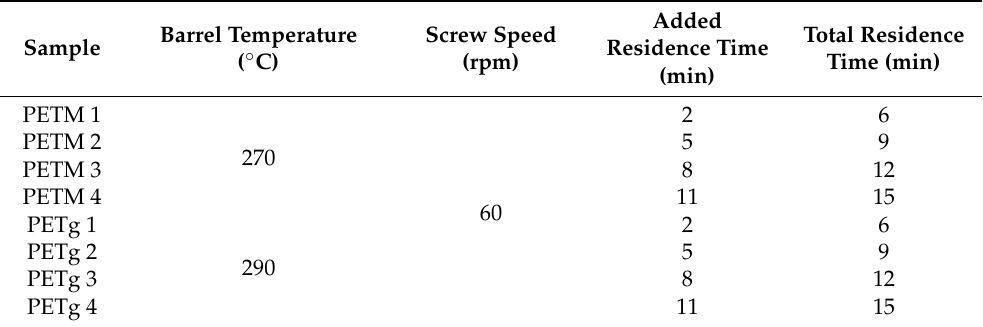
Table 1. Barrel temperature, screw speed and (total) residence time of the residence-time samples of PETM and PETg.